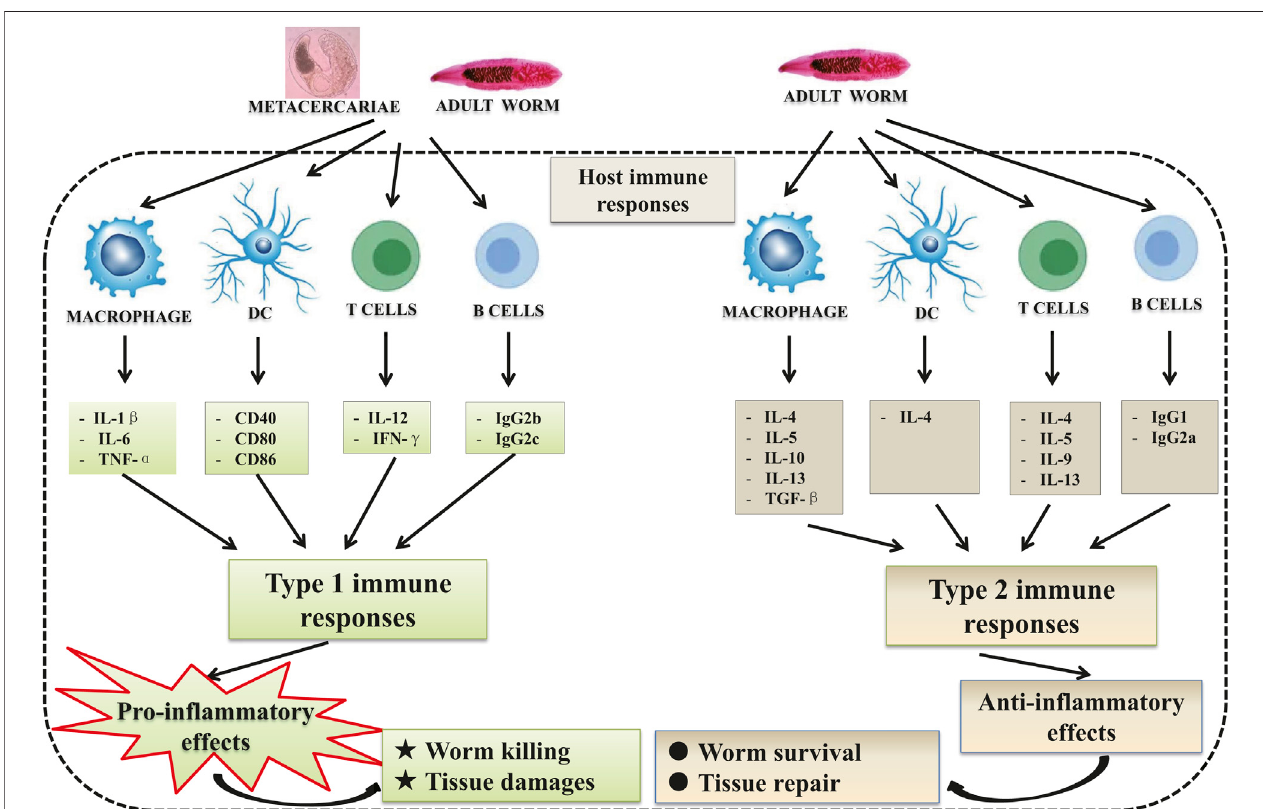
FIGURE 1 | Host immune responses during Clonorchis sinensis infection: C. sinensis infection leads to the activation of both innate and adaptive immune cells. During its life cycle within de fi nitive hosts, the parasite presents different stages of development leading to a different immune response depending on the stage of development. In the early stage of the infection, the juvenile stages (metacercariae) favor the type 1 immune reaction which is pro-in fl ammatory with the production of cytokinessuchasIL-1 β ,IL-6,andTNF- α bymacrophages,andIL-12,IFN- γ andIgG2b,IgG2cbyTcellsandBcells,respectively.Thispro-in fl ammatoryreactionis supposed to lead to the expulsion of the parasite and biliary injuries. Adult parasites, on the other hand, develop strategies that allow them to escape the host immune response. To do this, they trigger the type 2 immune reaction which is anti-in fl ammatory and pro- fi brotic, with the production of IL-4, IL-5, IL-10, IL-13, and TGF- β by macrophages and T cells, and IgG1, IgG2a by B